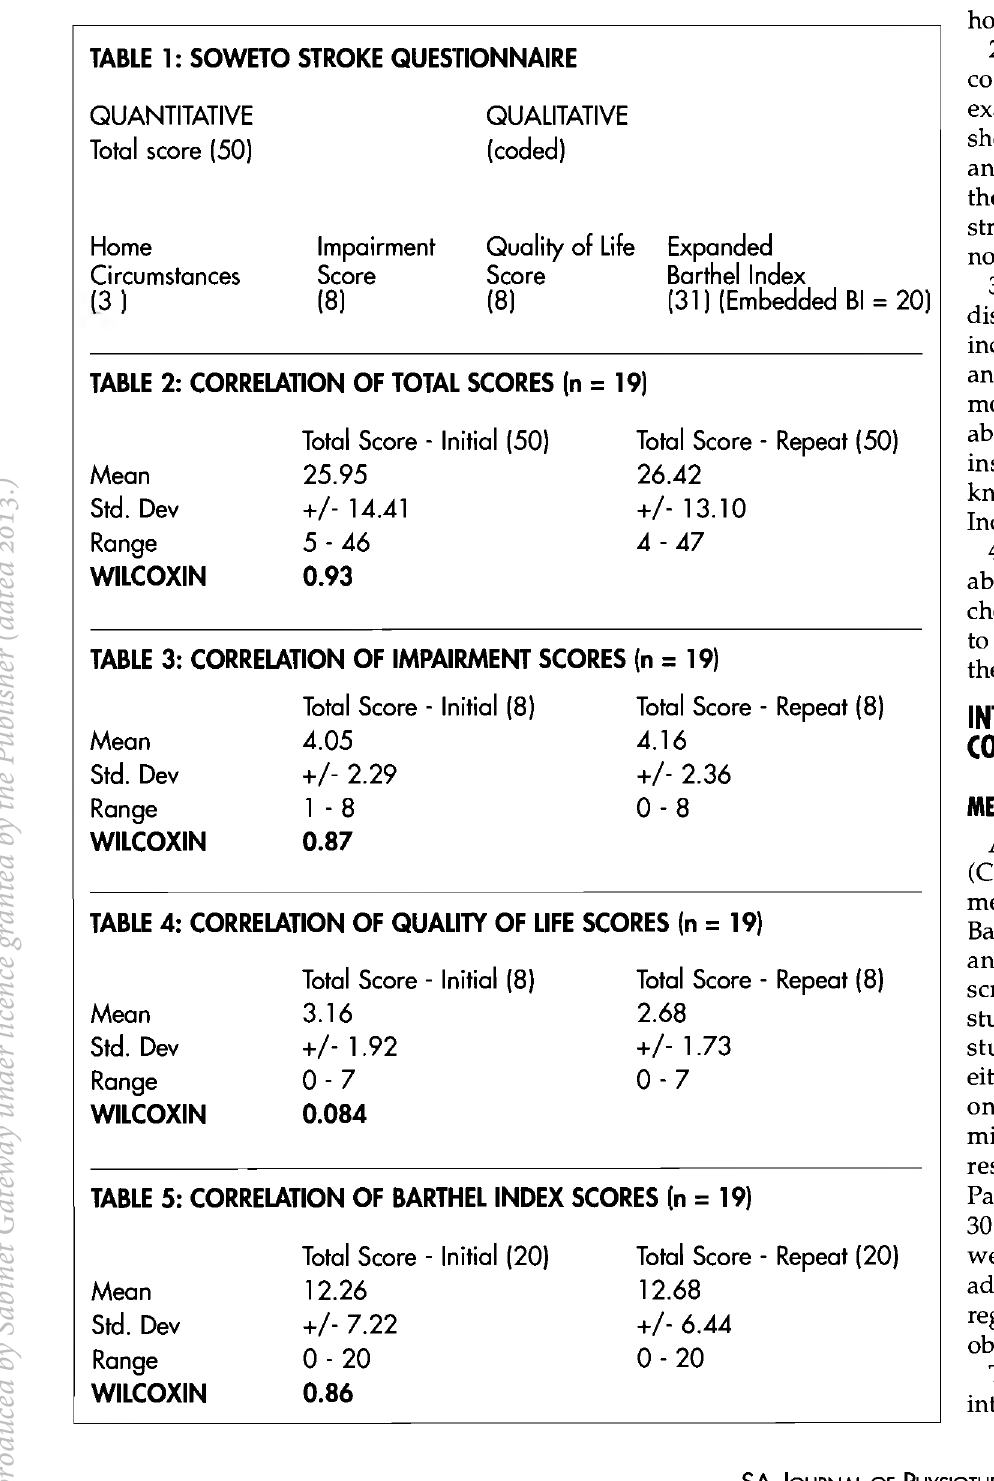
TABLE 1: SOWETO STROKE QUESTIONNAIRE QUANTITATIVE